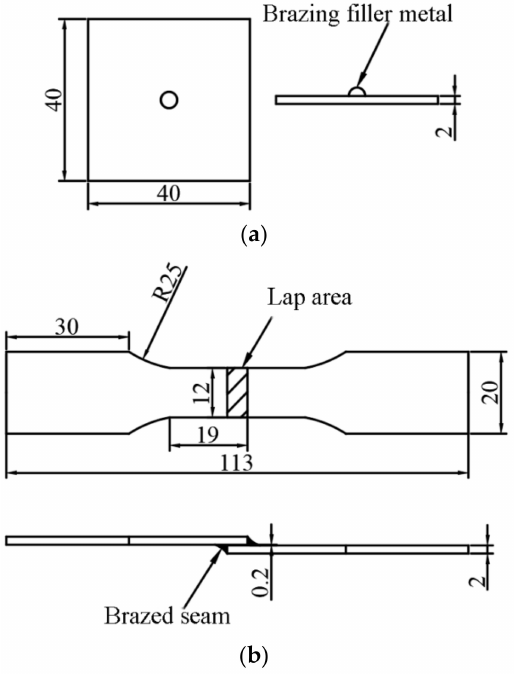
Figure 1. ( a ) Wet spread test specimen; ( b ) Brazed joint shear test specimen